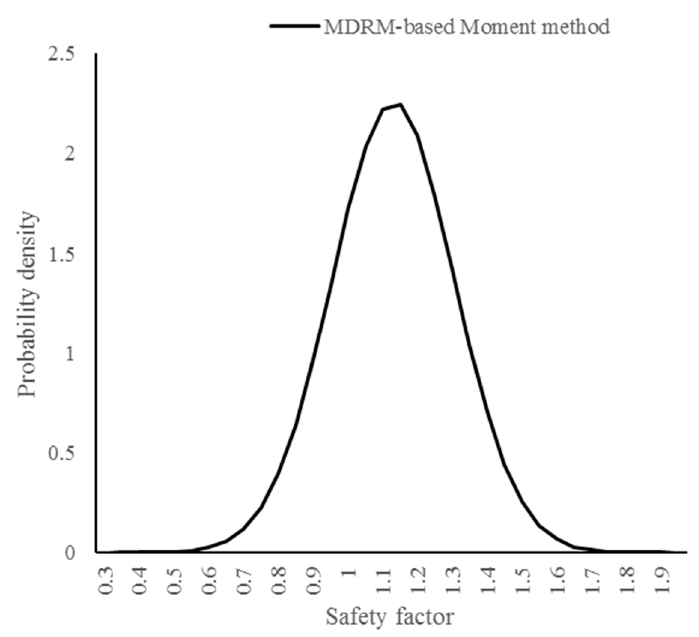
Figure 10. The probability distribution of safety factor using MDRM based reliability analysis.